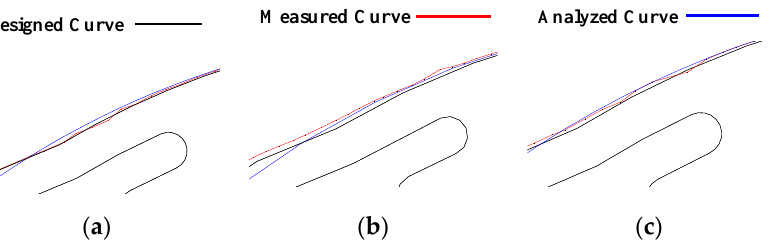
Figure 12. Measurement of eccentricity: ( a ) non-skew; ( b ) rotor-skew; and ( c ) stator-skew.